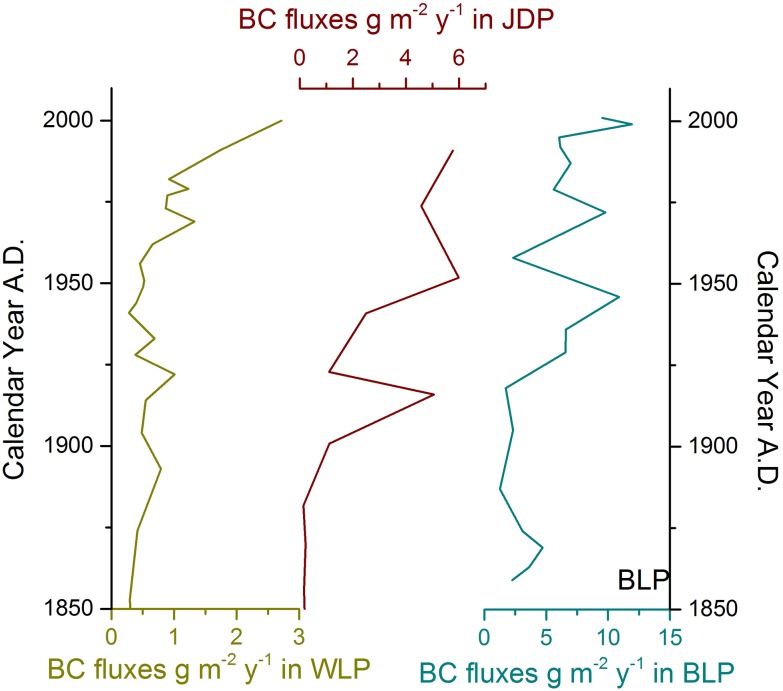
Historical variation of BC fluxes in WLP, JDP, and BLP profiles since 1850.